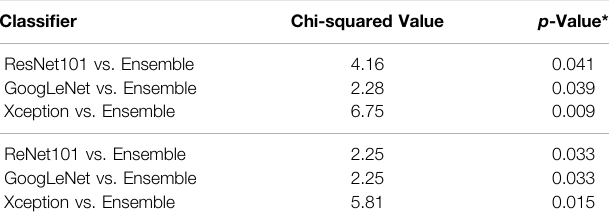
TABLE 4 | Signi fi cance of Ensemble classi fi er decision in comparison with individual classi fi ers. Classi fi er ResNet101 vs.